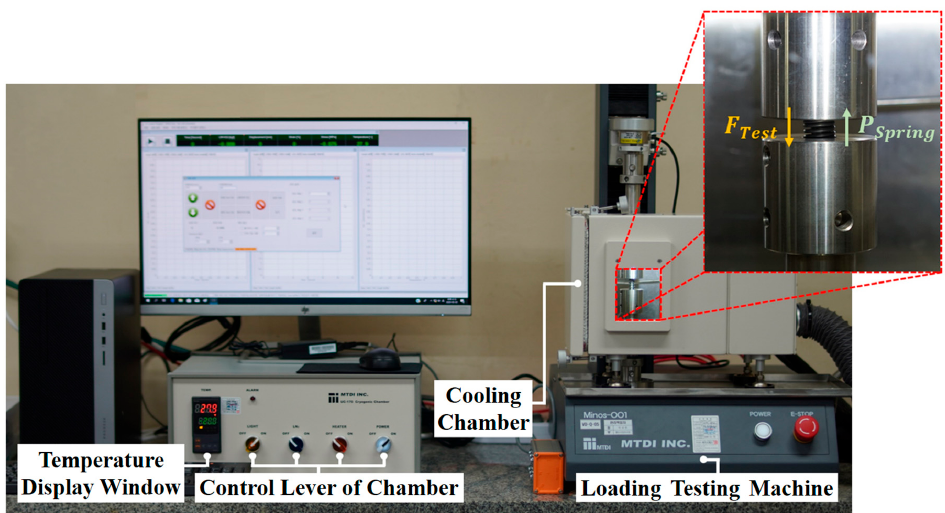
Figure 5. Experimentation setup for SMA coil spring characterization.